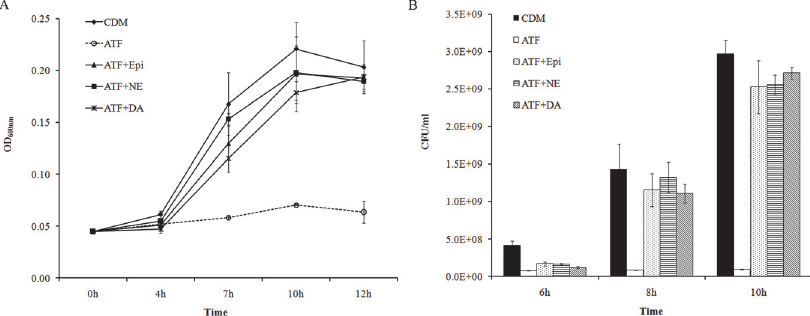
Fig 4. Catecholamine induced A . pleuropneumoniae growth in CDM containing ATF. A . pleuropneumoniae was cultured in TSB medium overnight and then sub-cultured into CDM using